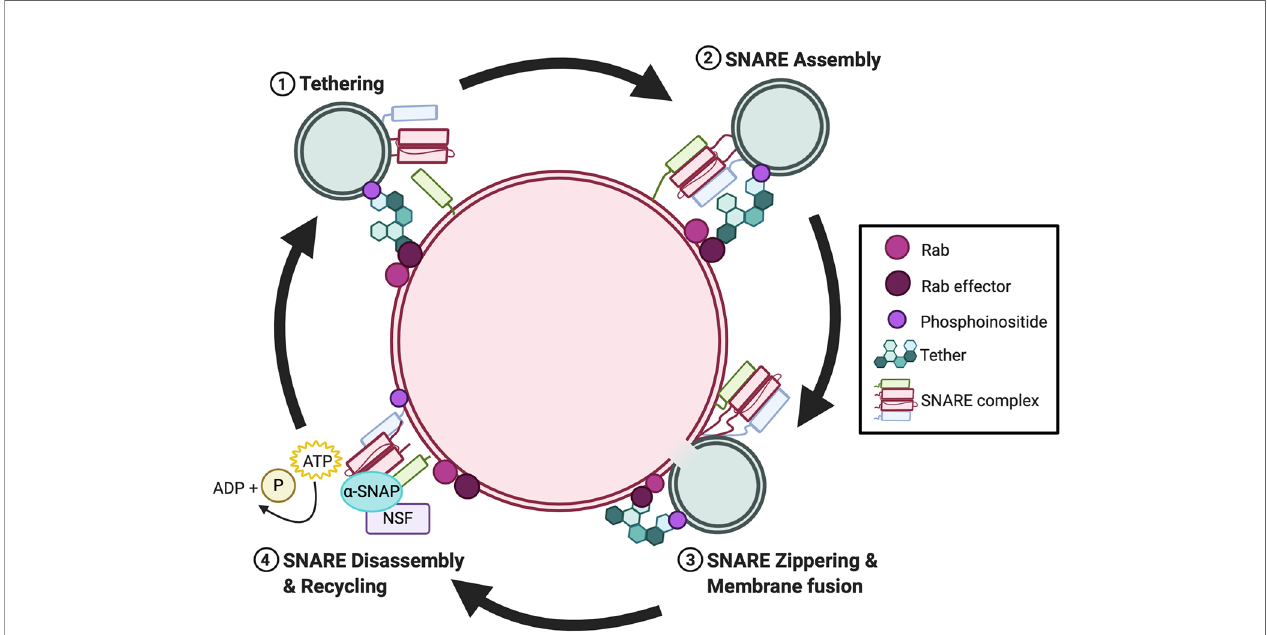
FIGURE 1 | Overview of the cyclical nature of membrane fusion. Rab GTPases and their effectors recruit tethers to the membrane fusion site during the tethering step. Subsequently, SNAREs are recruited to opposing membranes and assemble in trans via the catalyzing activity of a SM protein. Once assembled, SNARE zippering drives membrane fusion. Post-fusion, NSF and a -SNAP bind to the cis -SNARE and ATP-driven complex disassembly recycles the individual SNAREs intothe cytosol for